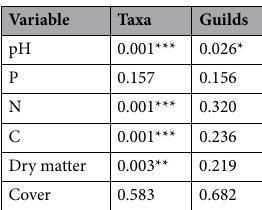
Table 2. Summary of p -values of the environmental variables influence over the three treatments fungal community distribution in the NMDs